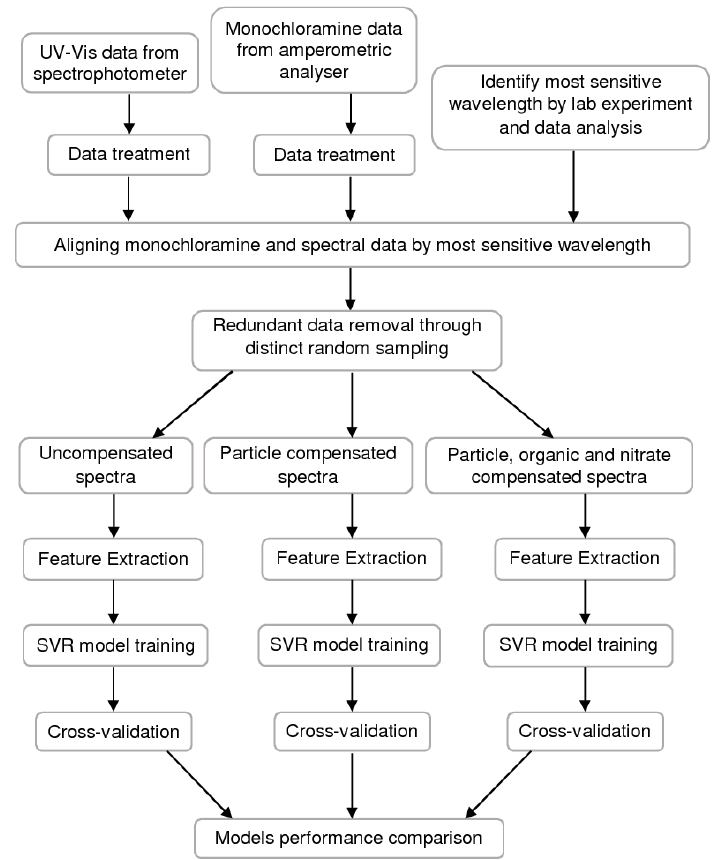
Figure 4. Work methodology.